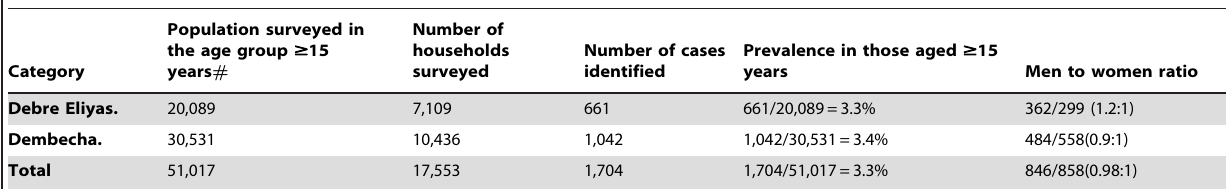
Table 2. Prevalence of podoconiosis